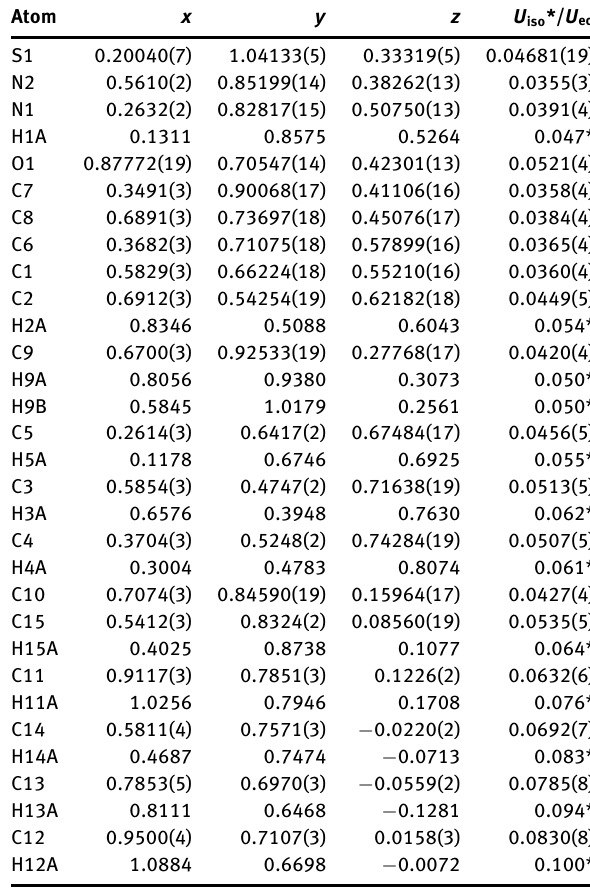
Table 2: Fractional atomic coordinates and isotropic or equivalent isotropic displacement parameters (Å 2